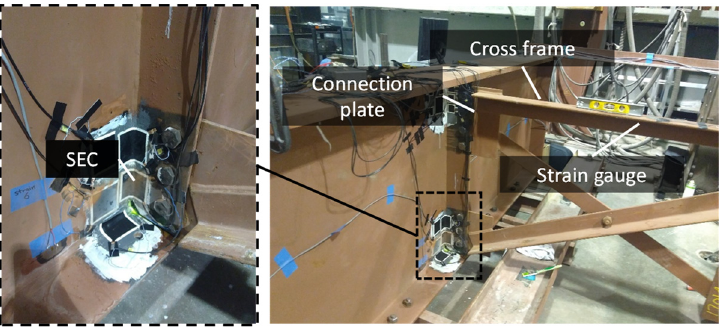
Figure 24. Laboratory non-skewed bridge girder test setup and the installed SECs and strain gauge [30].